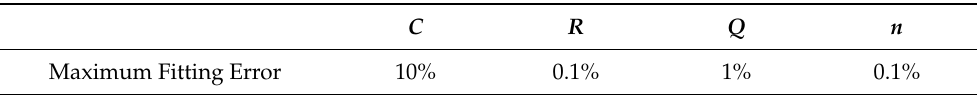
Table 4. Maximum error values for the estimation of circuit parameters, reported in Table 3, by fitting operation. C R Q